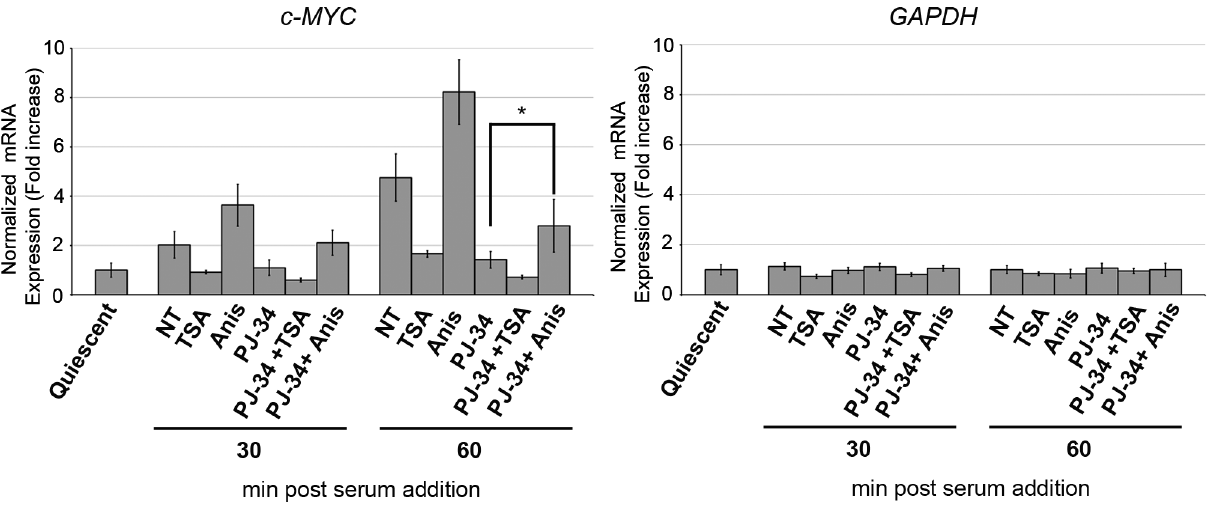
Figure 6. Anisomycin-stimulated phosphoacetylation restores c-MYC expression in the absence of PARP activity. c-MYC and GAPDH expression levels were assessed by RT-qPCR. Quiescent fibroblasts pre-treated with TSA or Anisomycin (Anis) or not-treated (NT), were serum- stimulated for 30 or 60 minutes in the presence or absence of PJ-34. Total RNAs were purified and the expression values obtained for c-MYC and GAPDH were normalized respect to TBP and plotted as relative to the control sample corresponding to quiescent cells. The error bars represent the SD of three biological replicates. Statistical significance: *: P , 0.05.